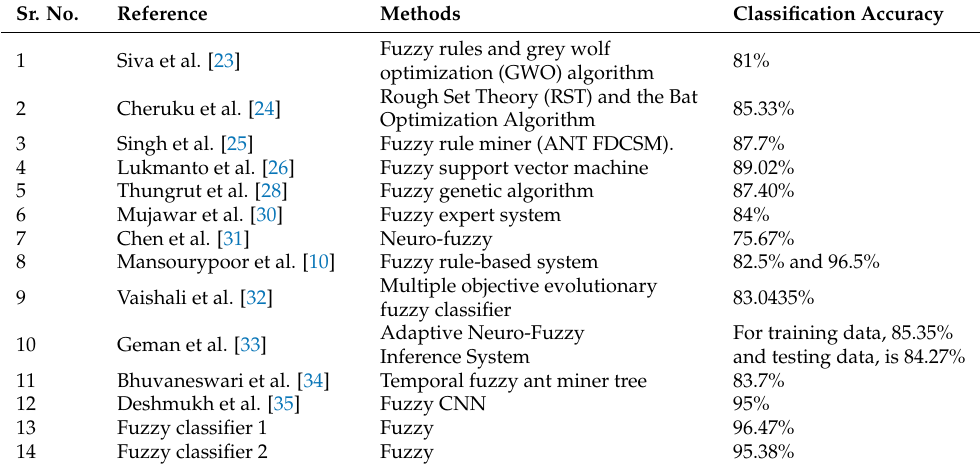
Table 7. Comparison of our fuzzy classifiers with other fuzzy techniques. Sr. No.